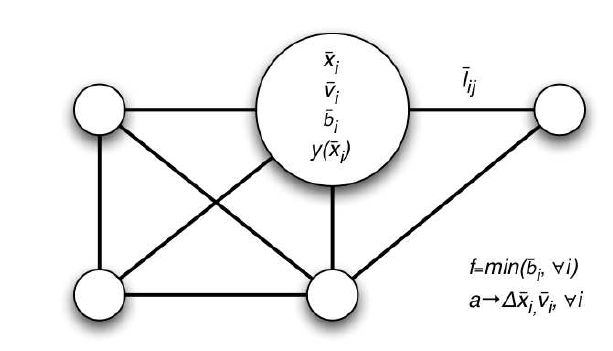
Figure 3. Schematic of an PSO instantiation of a CN. Each node contains the position x i and velocity v i of a particle, as well as its best solution found b i and a function y ( x i ) . Edges contain the neighborhood’s best solution lij . Function f is the best solution found by all parti- cles. Algorithm a changes the position x i and velocity v i of particles depending on the values of their neighbors.